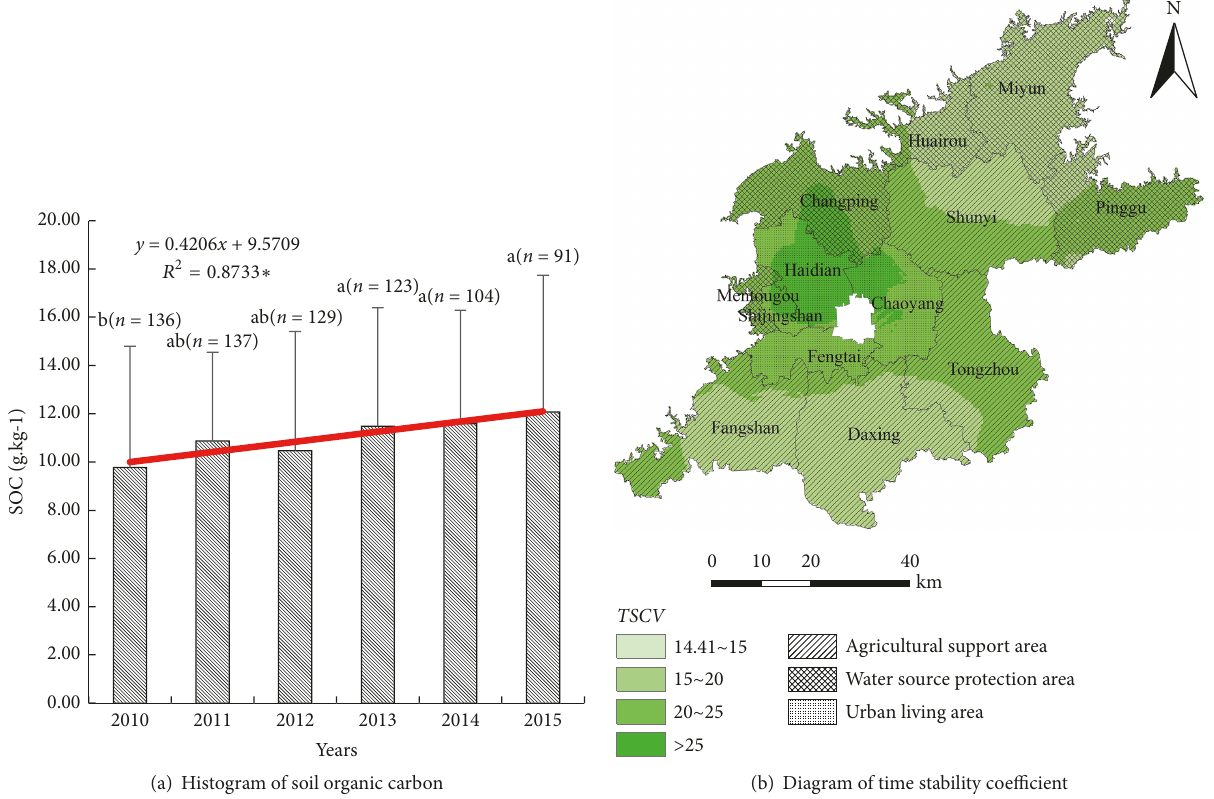
Figure 3: The interannual variation and spatial distribution of soil organic carbon and its trend. Values in each row with the same letter are not significant ( 𝑃 > 0.05 ). In the equation, x and y, respectively, represent the year number (1, 2, .. . , 6) and soil organic carbon